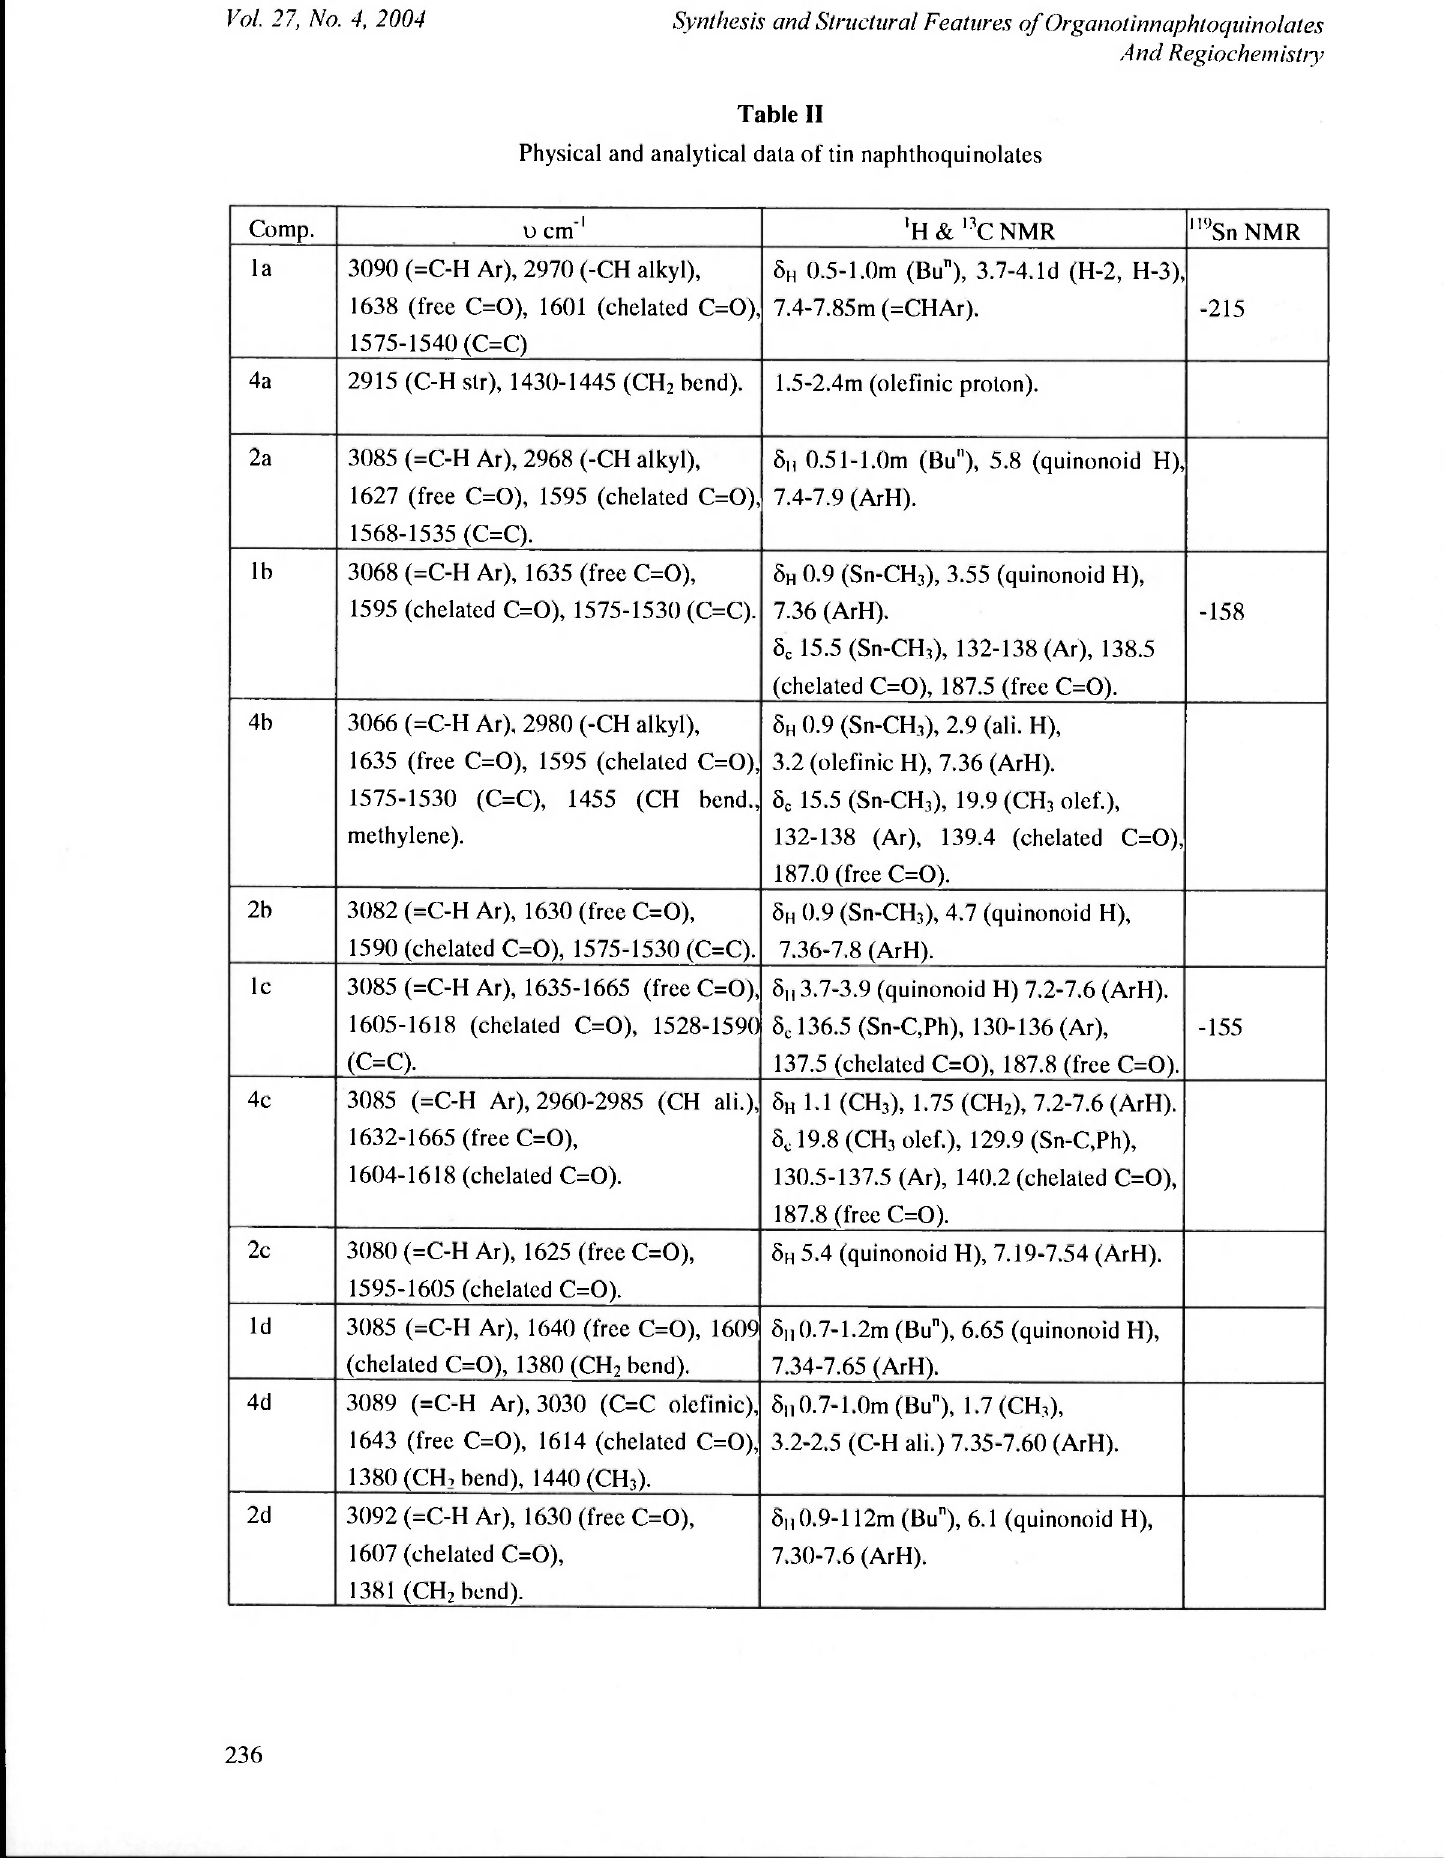
Physical and analytical data of tin